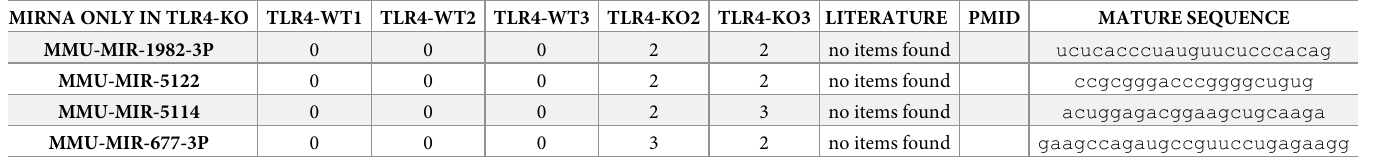
We noted that miR-96-5p, miR-5122 and miR-1982 showed a very low expression in both genotypes, and no significant difference was found when comparing the WT vs . The TLR4-KO mice. It is noteworthy that when PCR cycles were used, miR-96-5p and miR-5122 were detected, but miR-1982 was not detected by real-time PCR. After corroborating that the TLR4-KO genotype presented an altered miRNAs pattern in both quantity and diversity by RT-qPCR, we decided to perform a functional analysis with the 52 miRNAs found exclusively in the WT mice with the mdgsa package (Fig 3A). RT-qPCR provided us with information which indicated that the miRNAs not detected in TLR4-KO by the NGS data were detected by qPCR, but at a very low level compared to the WT mice. The bioinformatics results are offered in Fig 3C. Remarkably this figure depicts a strong regulation on routes like neuron death, apoptosis processes and synapsis organization, among others. These results suggest a lower regulation of TLR4-KO during these important routes/processes than the WT mice. Table 4. Exclusive miRNAs in the TLR4-KO mice. The table shows the total counts and a selected article about their